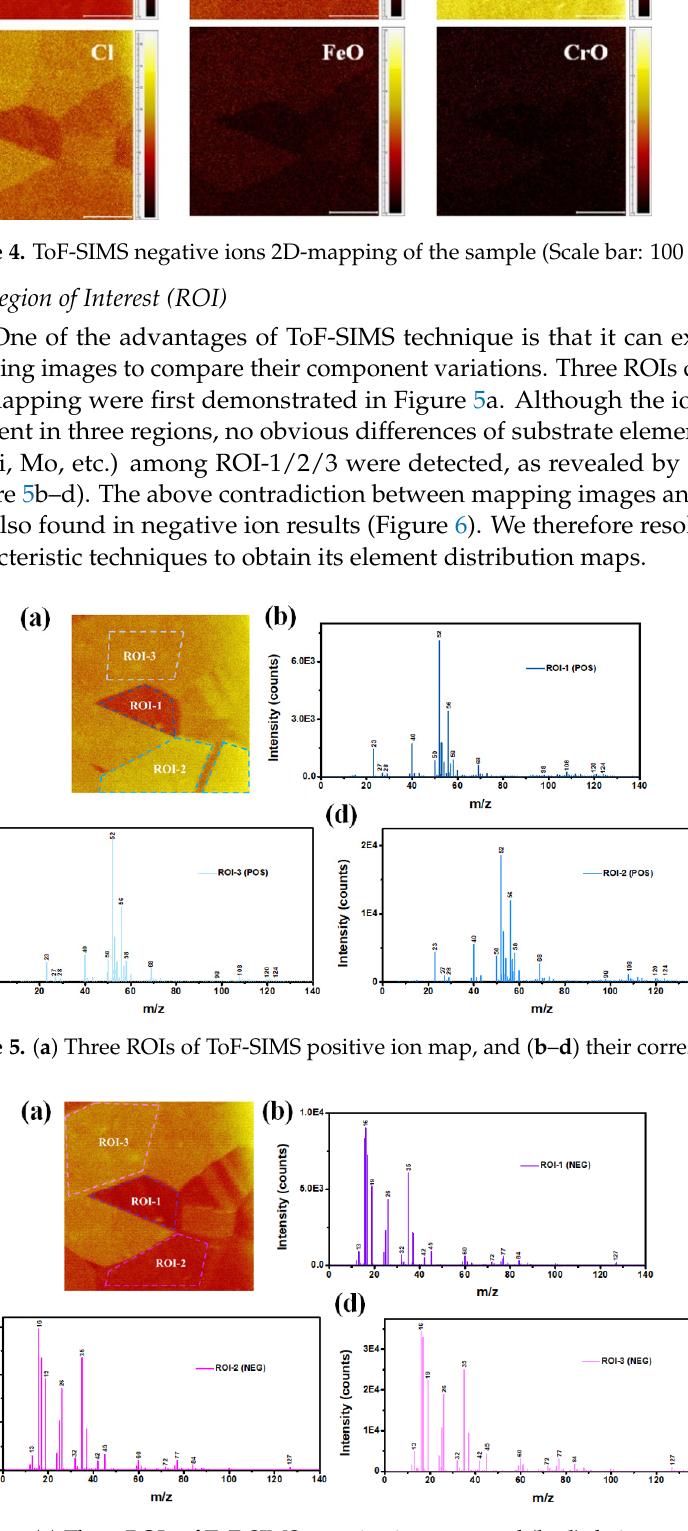
Figure 6. ( a ) Three ROIs of ToF-SIMS negative ion map, and ( b – d ) their corresponding mass